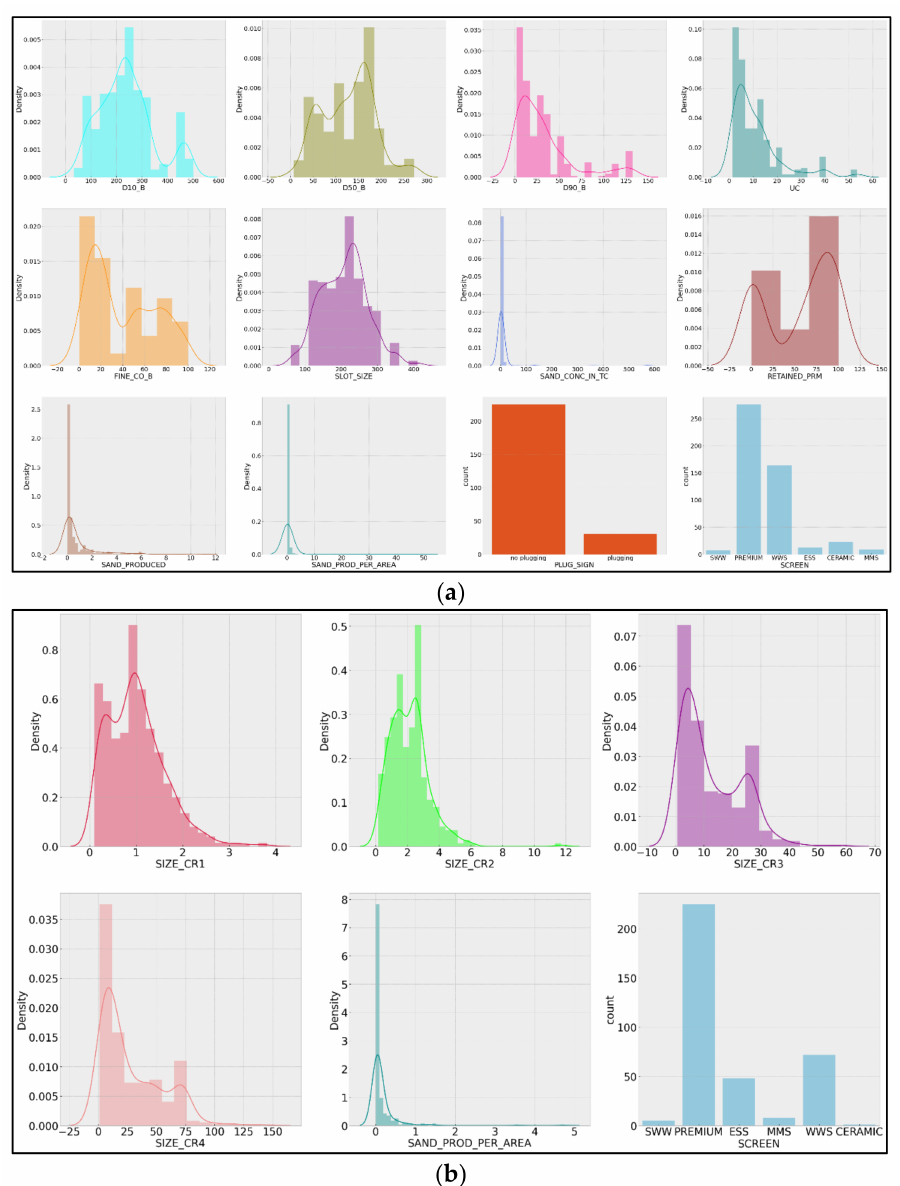
Figure 3. Distribution plot of sand retention test (SRT) variables. ( a ) Slurry test variables; ( b ) sand pack test